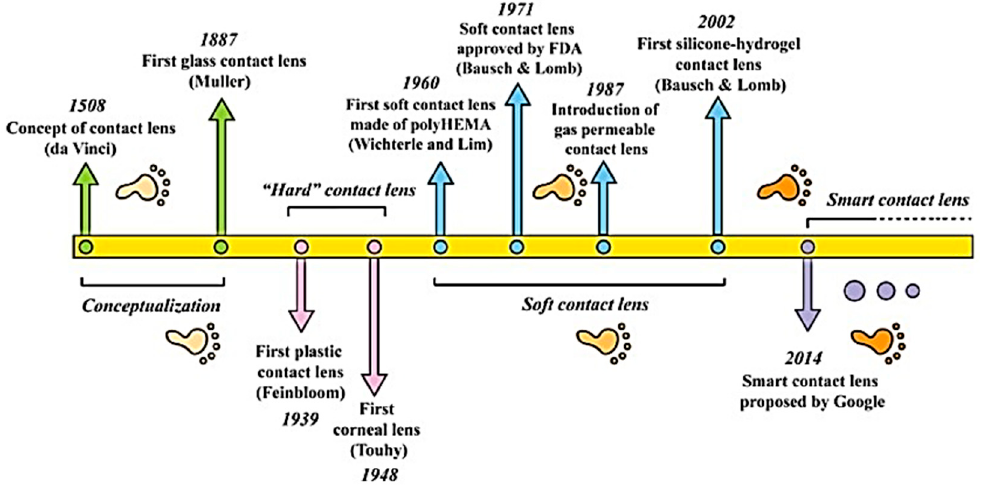
Figure 2. The milestones of contact lens development. Reprinted with permission from reference [24]. Copyright 2021 John Wiley and Sons.